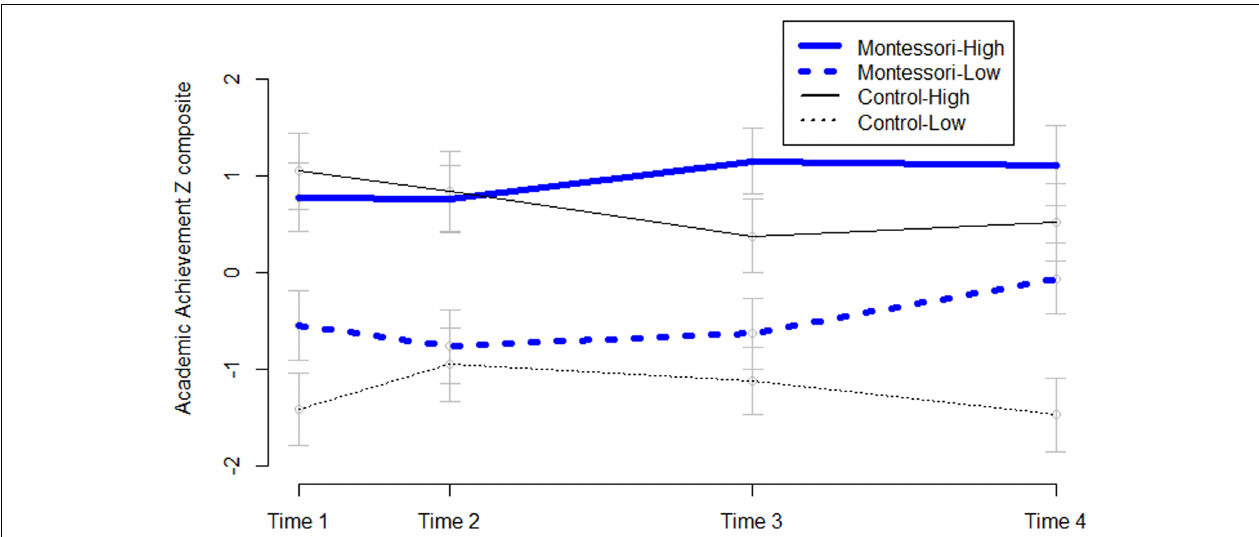
FIGURE 5 | Academic achievement across four time points by school condition and income group. Although equal to the lower income control children at Time 1, by Time 4 the lower income children in Montessori showed a strong positive trajectory towards closing the achievement gap with the higher income children in control and Montessori schools. Standard error bars are